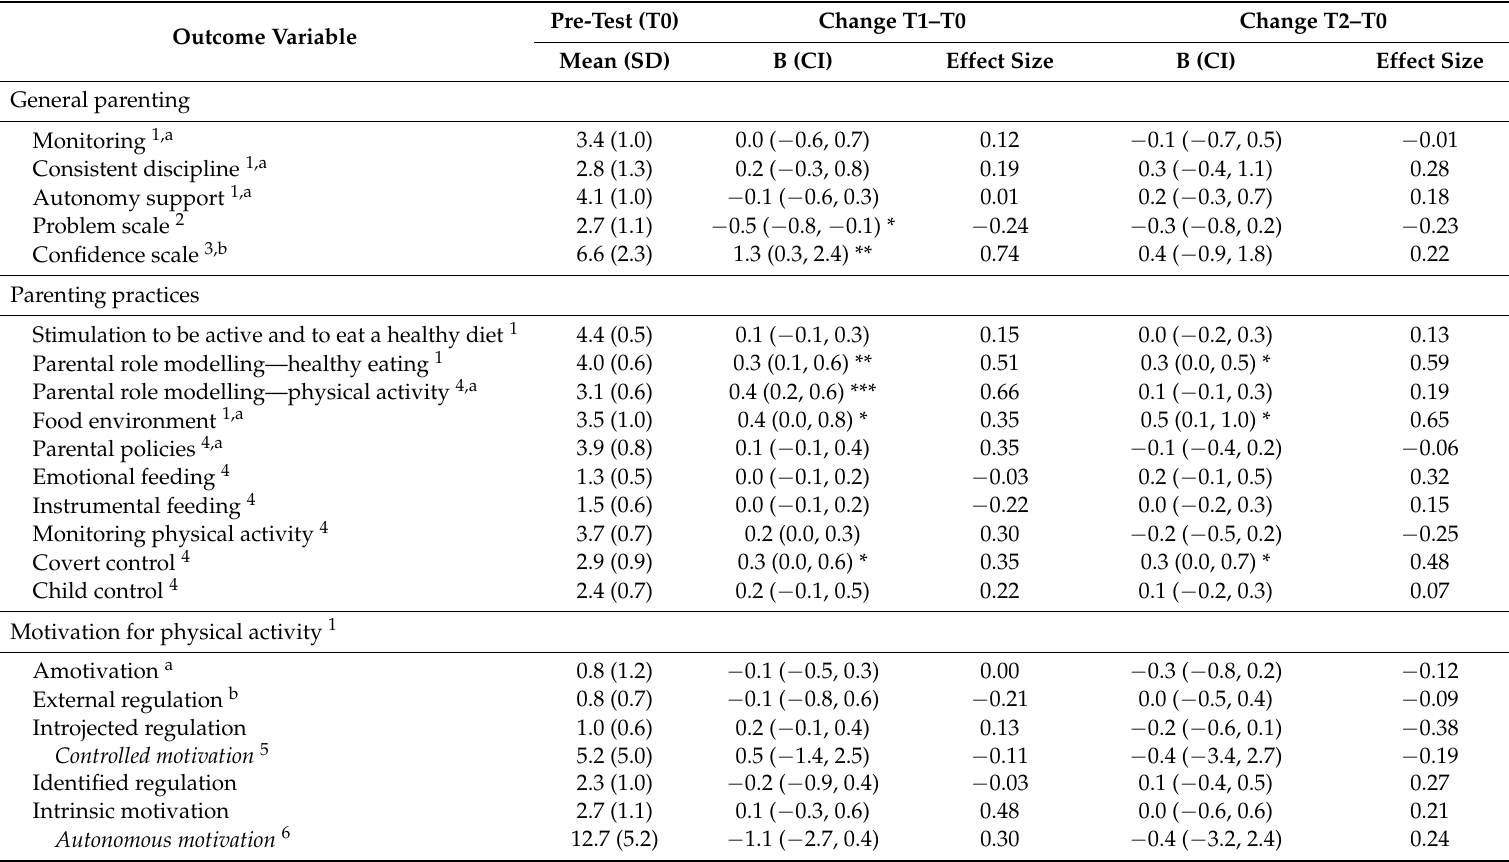
Table 3. Average change reported by parents and children regarding parenting, motivation for physical activity and healthy diet, behaviour-specific cognitions, physical activity, dietary behaviour, sleeping behaviour, quality of life and BMIz, at T1 and T2, analysed with linear mixed